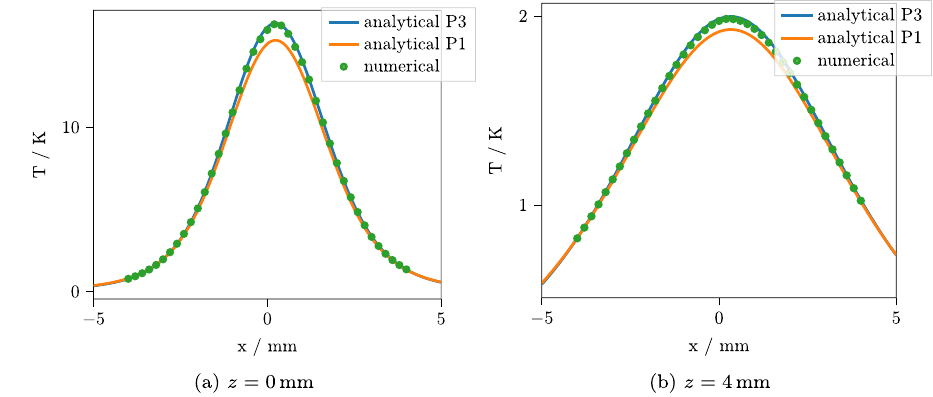
0 for two different 60 ◦ along the line y = =